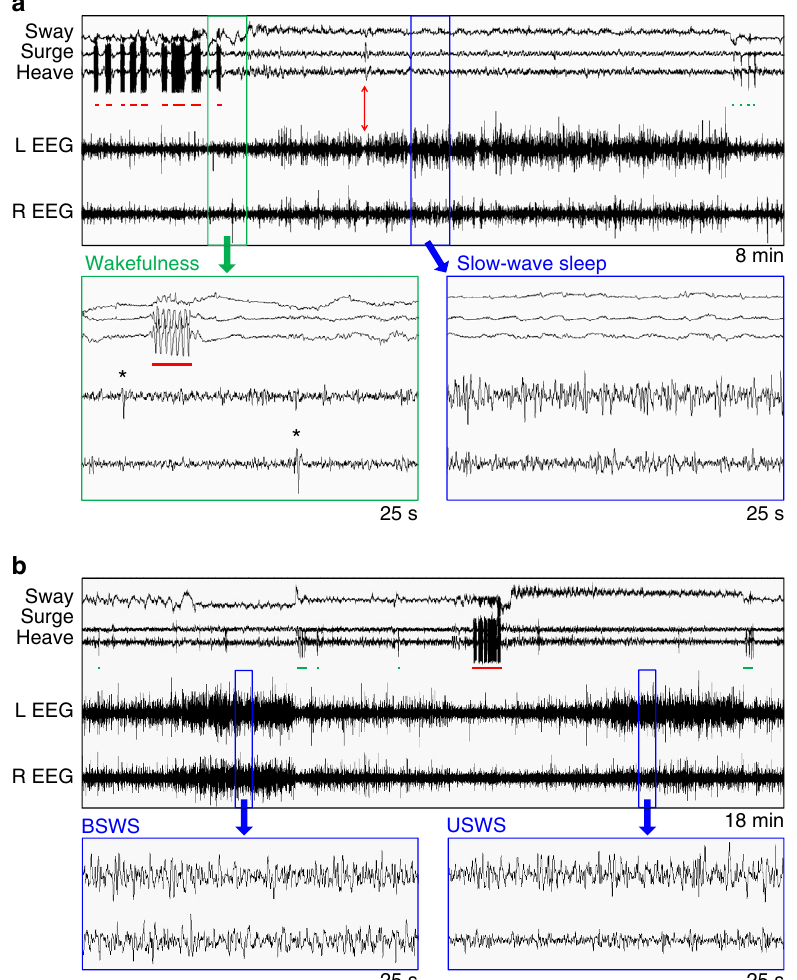
Figure 2 | Unihemispheric and bihemispheric sleep in flight. ( a ) Recording of head acceleration in three dimensions (sway, surge and heave) and electroencephalogram (EEG) activity from the left (L) and right (R) hemispheres showing the transition from wakefulness to SWS following the cessation of flapping (red bars). Brief episodes of dropping (green bars) occur after this episode of sleep. Expanded views (bottom) show wakefulness characterized by low-amplitude, high-frequency EEG activity in both hemispheres, infrequently punctuated by isolated high-amplitude, slow waves (*), and SWS characterized by continuous high-amplitude, slow waves, in this case, primarily in the left hemisphere. The red arrow (top) marks an episode of apparent REM sleep (expanded in Supplementary Fig. 13). ( b ) Recording from the same bird showing an episode of bihemispheric SWS (BSWS) and unihemispheric SWS (USWS), including expanded views of both states. The mean duration of episodes of sleep was shorter than these long episodes used to demonstrate USWS and BSWS in flight. These recordings are from frigatebird 13 (Supplementary Fig.